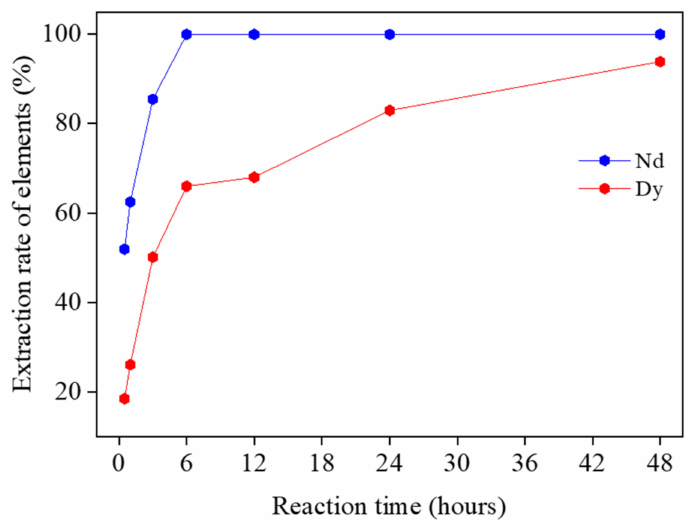
Figure 1. Variation of Nd and Dy extraction efficiency with increasing